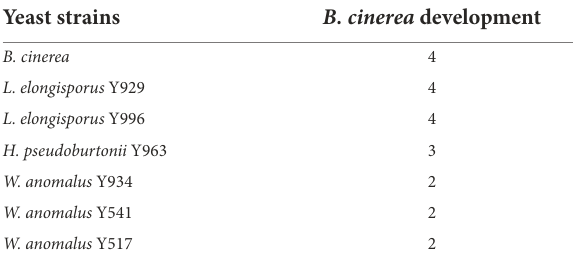
TABLE 5 In vivo test of the selected various yeast species against Botrytis